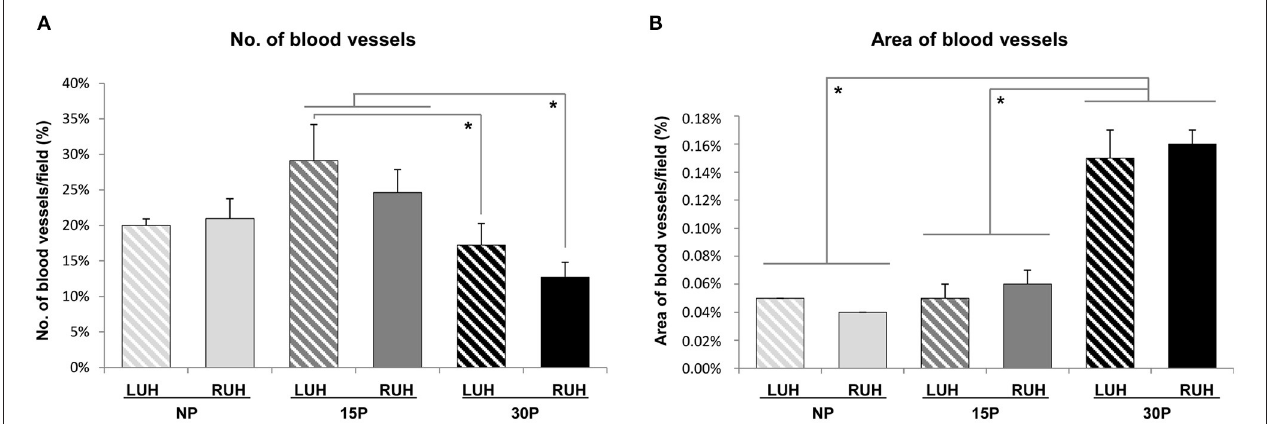
FIGURE 6 | Effect of pregnancy status and stage of pregnancy on the blood vessel number and area in the endometrium of alpacas. (A) Number of blood vessels in LUH (left uterine horn) and RUH (right uterine horn) of non-pregnant (NP), 15 days-pregnant (15P), and 30 days-pregnant (30P) alpacas. (B) Percentage of the endometrial area occupied by blood vessels in LUH and RUH. Histograms illustrate mean values ± SE. Asterisks indicate significant differences (* p < 0.05